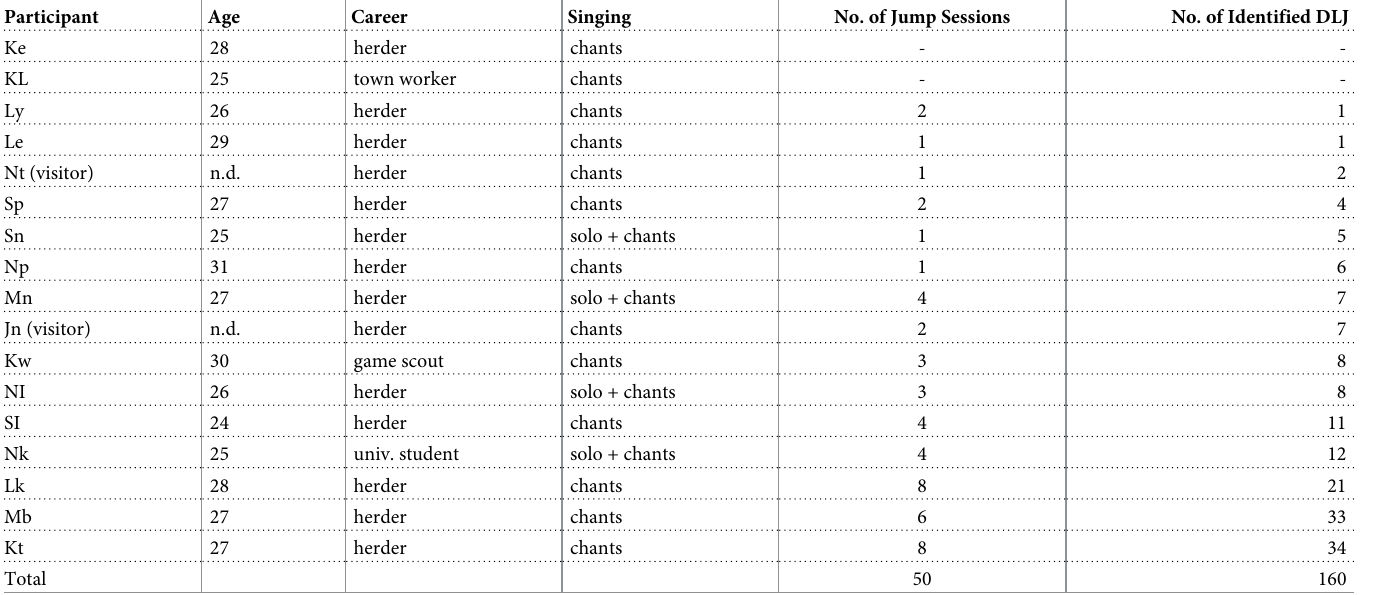
Table 1. Sociodemographic features and performance patterns of individual youth.